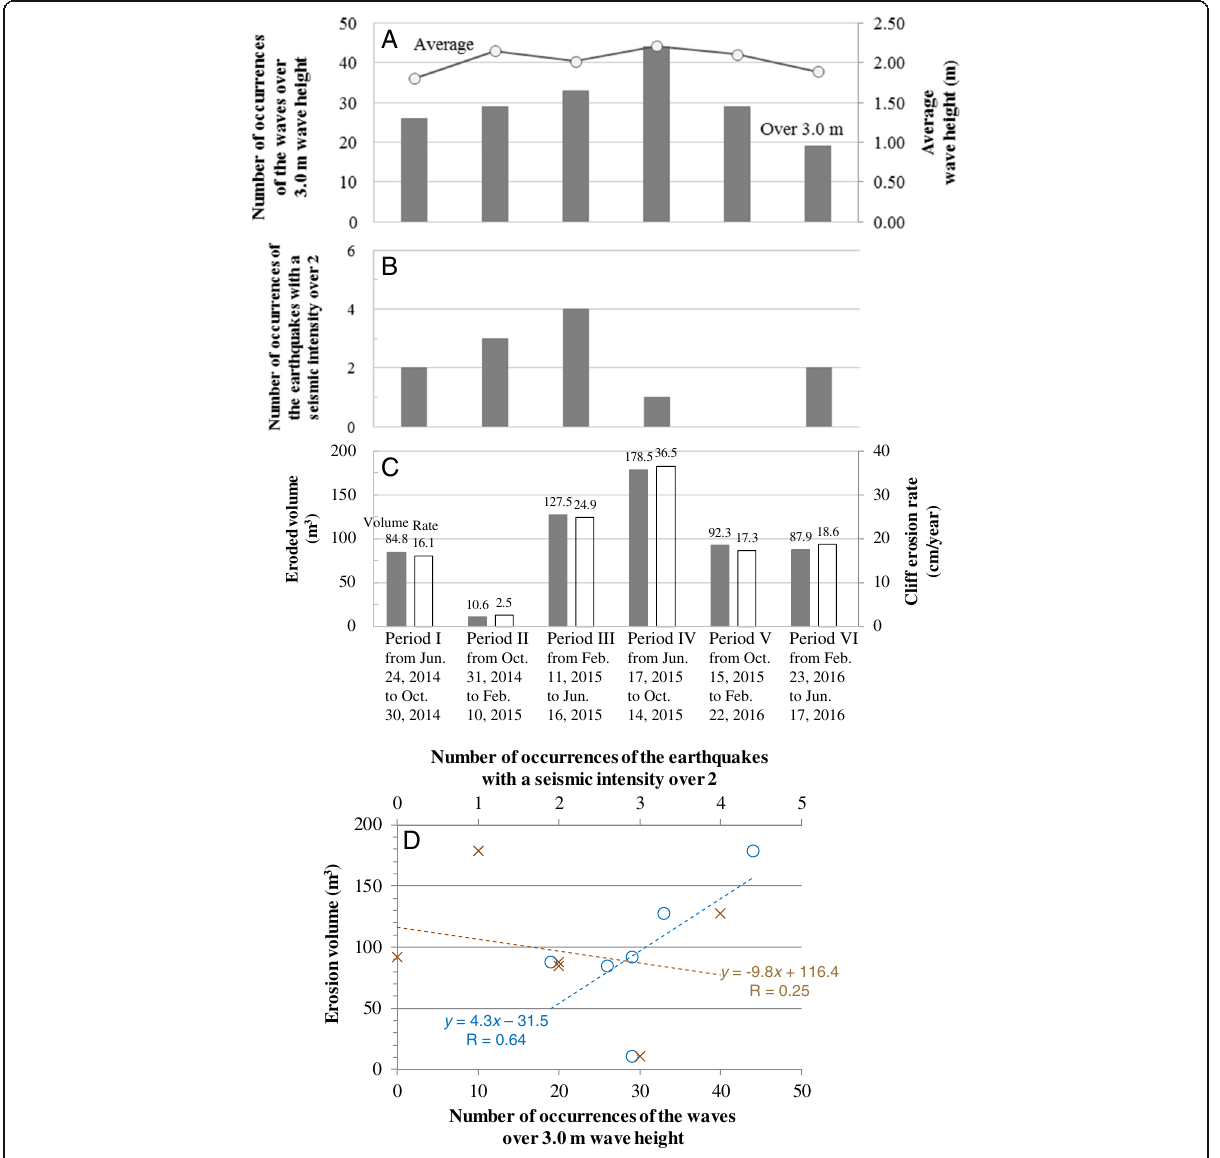
Number of occurrences of the waves over 3.0 m wave height Fig. 5 Changes in the occurrences of potential triggering factors and cliff erosion between survey periods. a Wave height at Bosohanto-oki. b Earthquake at Choja, Misaki-machi, Ishumi-shi. c Erosion rate of the cliff. d Relationships between potential triggering factors and eroded volume. Blue-colored circles are wave datasets and brown-colored x-marks are earthquake